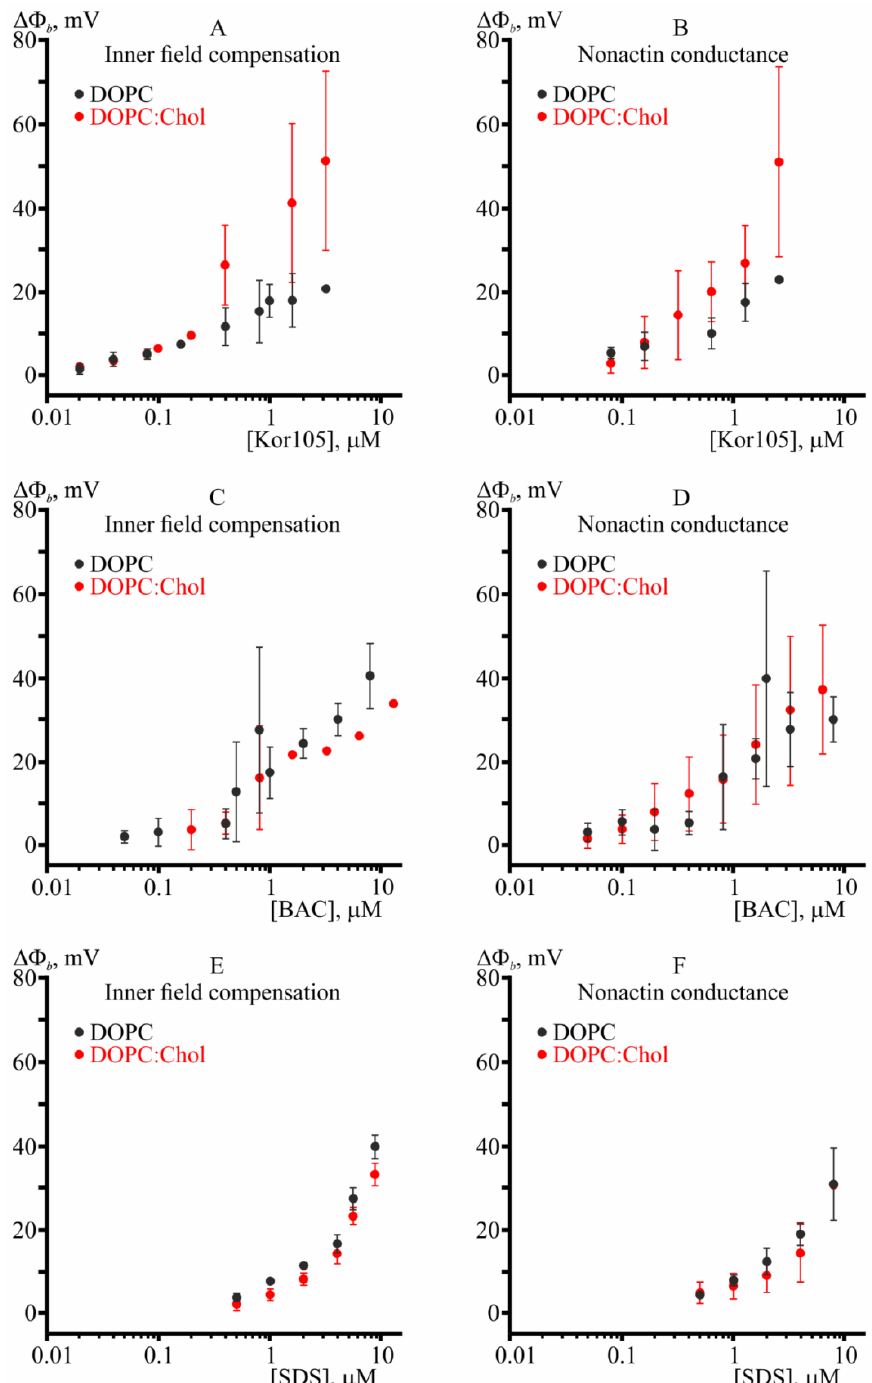
Figure 4. Kor105, BAC, and SDS interaction with BLMs. Panels A and B show the boundary potential difference measured after the addition of increasing concentrations of Kor105. Panels C and D show the boundary potential difference measured after the addition of increasing concentrations of BAC. Panels E and F show the sign-inversed boundary potential difference measured after the addition of increasing concentrations of SDS. The boundary potential measured using the IFC method is demonstrated in panels A, C, and E. The boundary potential measured using the nonactin conductance method is demonstrated in panels B, D, and F. The data obtained on DOPC membranes are shown as black solid circles; the data obtained on DOPC/Chol 3:2 membranes are shown as red solid circles. The data points are the same, as presented in Figure 3, but combined in order to present DOPC vs. DOPC/Chol curves in the same graph.